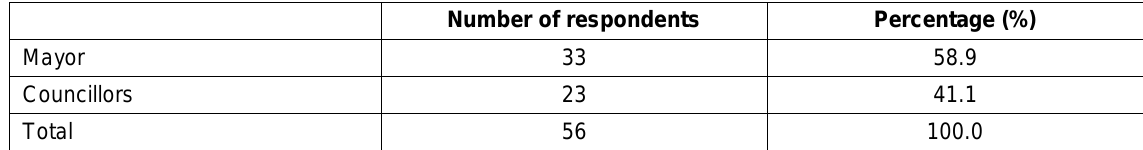
Table 9: Views on who is the vital role player in decision-making (representatives and officials)